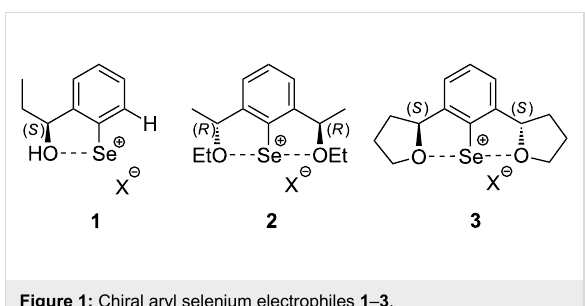
Figure 1: Chiral aryl selenium electrophiles 1 – 3 .